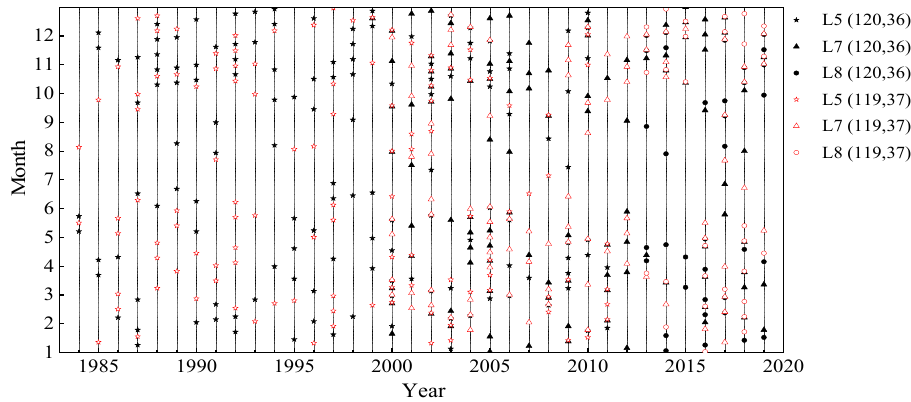
Figure 2. Satellite remote sensing image data.